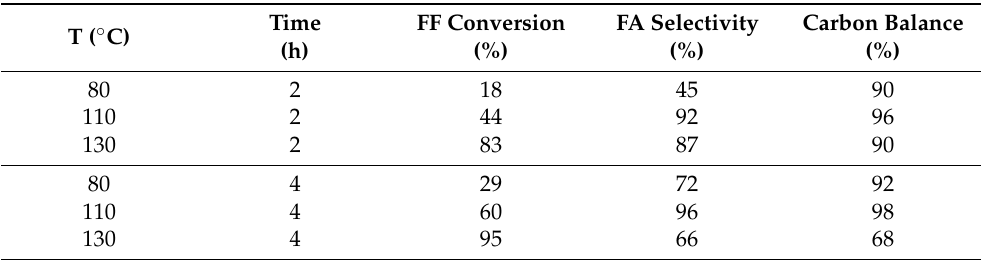
Table 3. Effect of reaction temperature on the oxidation of furfural using 2% Au/TiO 2 catalyst. (P(O 2 ) = 15 bar, 600 rpm, FF/Au =